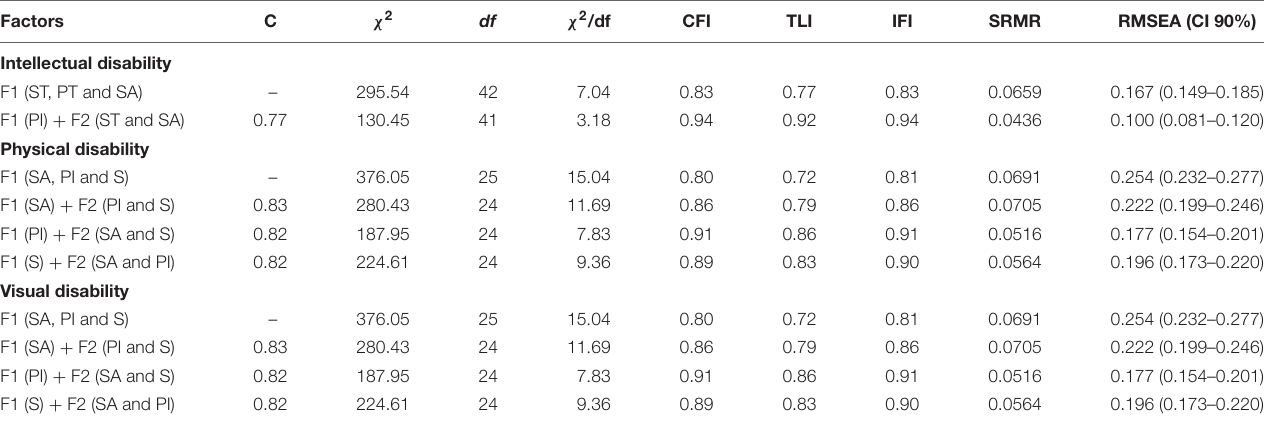
TABLE 1 | Alternative factor models of the three